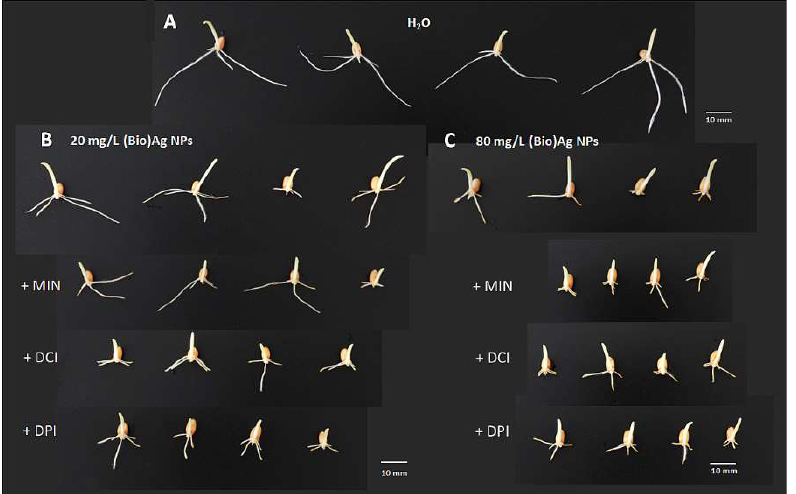
Figure 2. The morphology of 3-day-old seedlings of wheat ( Triticum aestivum L. cv. Ostka Strzelecka) growing in the absence ( A ) or presence of (Bio)Ag NPs alone (at ( B ) 20 and ( C ) 80 mg/L) and in mixtures with cyclitols— myo -inositol (+ MIN), D - chiro -inositol (+ DCI) or D -pinitol (+ PIN)—at 100 mM concentration each ( B , C ). Horizontal white bars correspond to 10 mm.